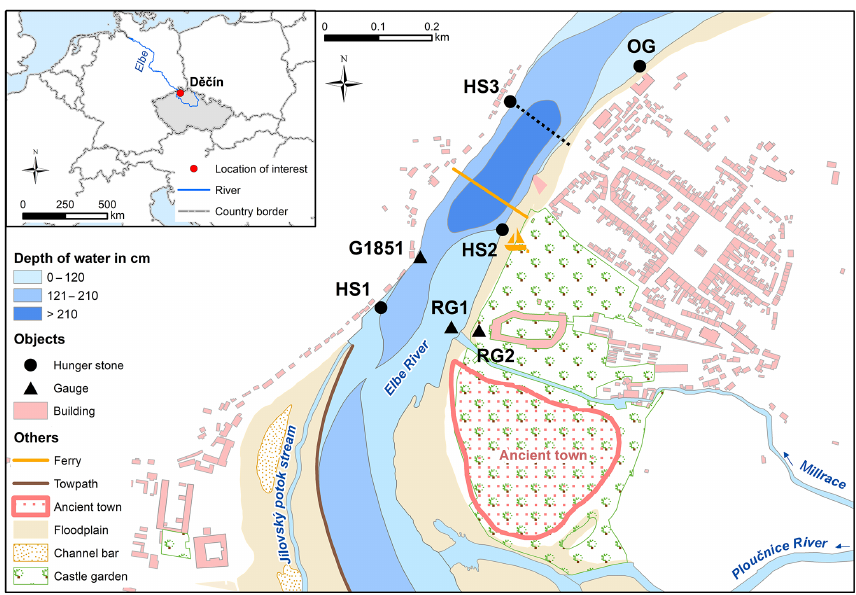
Figure 1. The city of Dˇeˇcín in 1842 with indications of the original extinct town (13th–14th century), area of shallows (lightest blue), water gauges RG1, RG2, G1851 and OG, and three hunger stones (HS1, HS2,